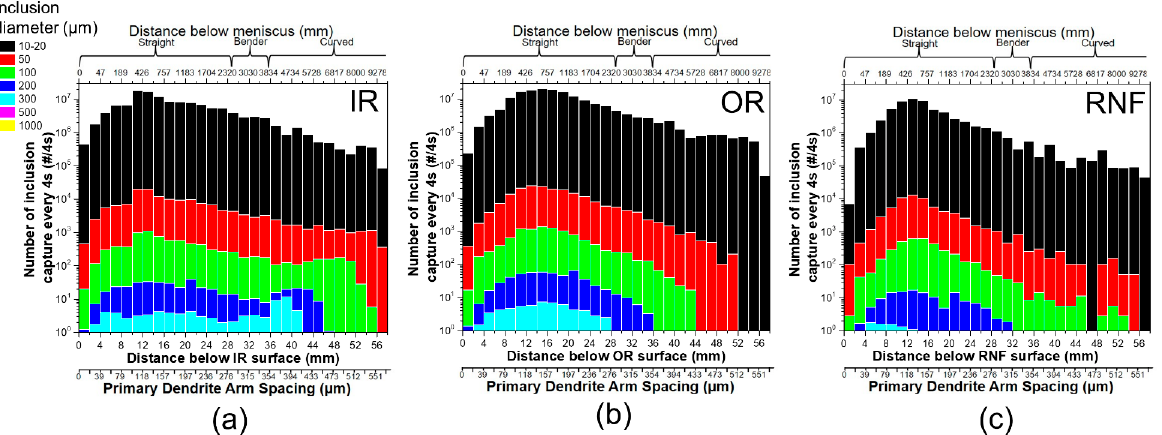
Figure 13. ( a ) Effective injection time (per 10,000 particles of each size), t pre,i and ( b ) time scale factor, S i , by inclusion size.